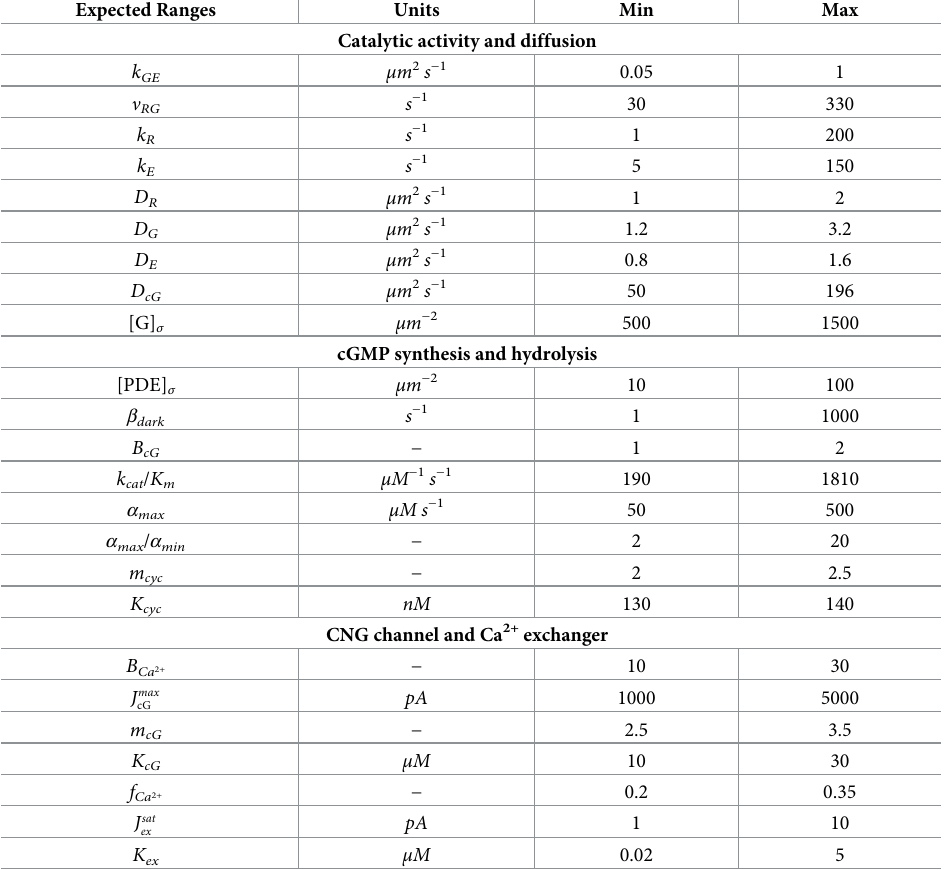
Table 8. Parameter ranges within which there was no penalty imposed by the Metropolis-Hastings search. The geometric parameters were held fixed at R b = 0.6 μm , R t = 0.4 μm , H = 13.4 μm , � 0 = 16.8 nm , ν = 0.65, ω 0 = π , and